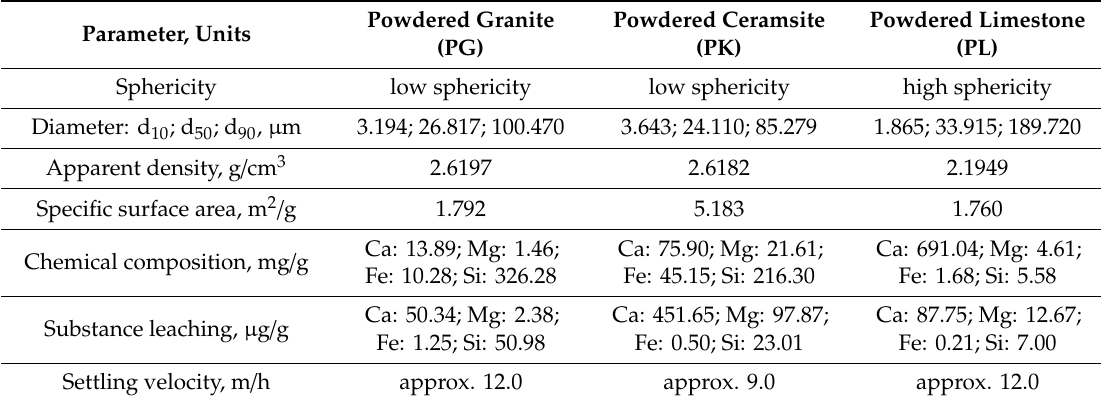
Table 4. Characteristics of powdered mineral materials.